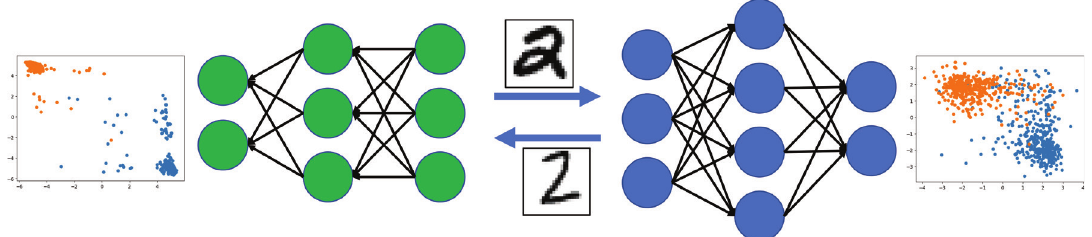
Figure 4: Two trained neural networks can communicate with each other by receiving generated images from the other network and returning images of the same